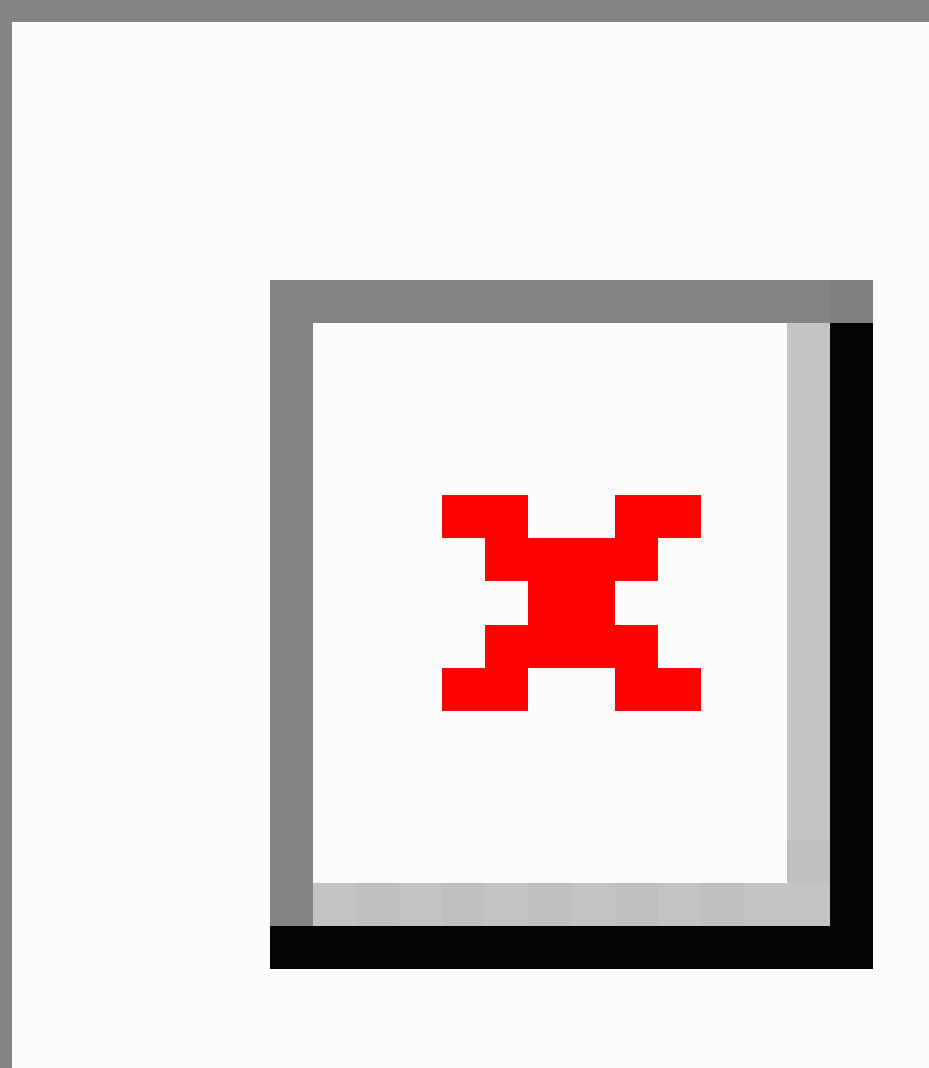
Figure 3. Cochrane risk of bias assessment: summary of each risk of bias